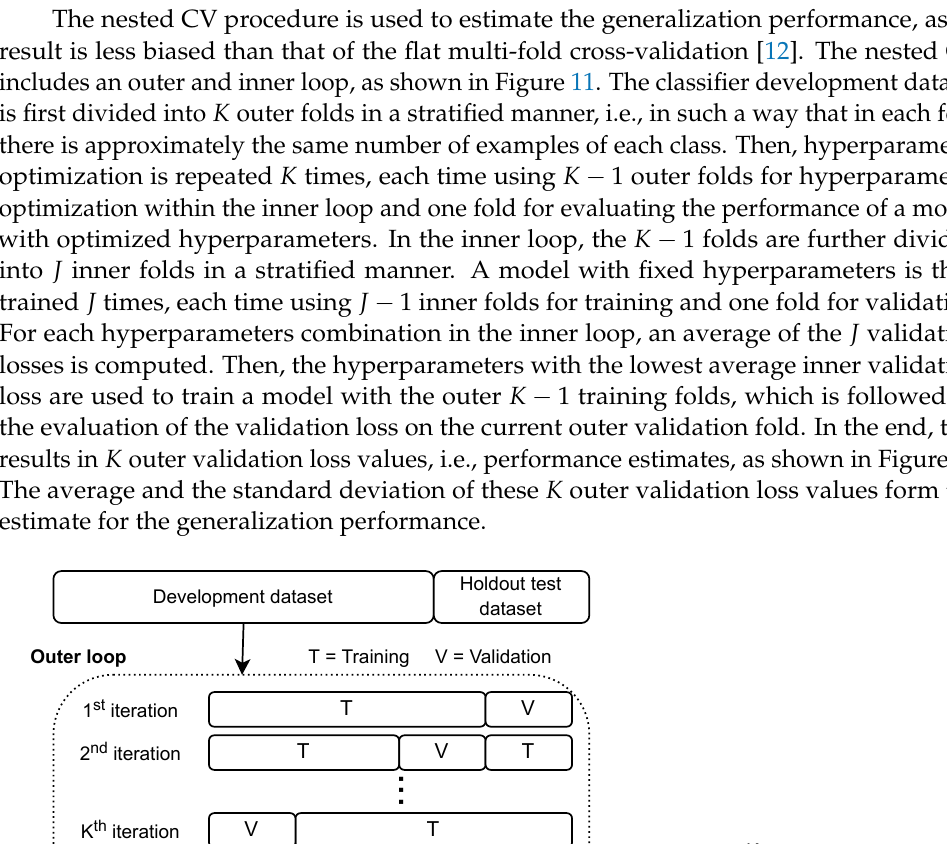
a Recursive feature elimination. b Synthetic minority oversampling technique.